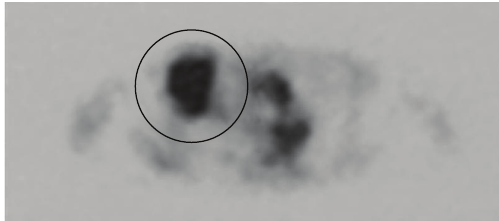
Figure 4: FDG-PET at 13 months after SBRT. High FDG uptake (SUVmax = 5 . 61) was observed for the